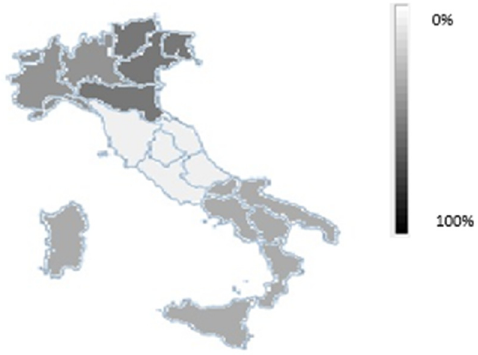
Figure 2. Geographical distribution of agricultural insurance. Source: Personal elaboration on SICURAGRO data [51].